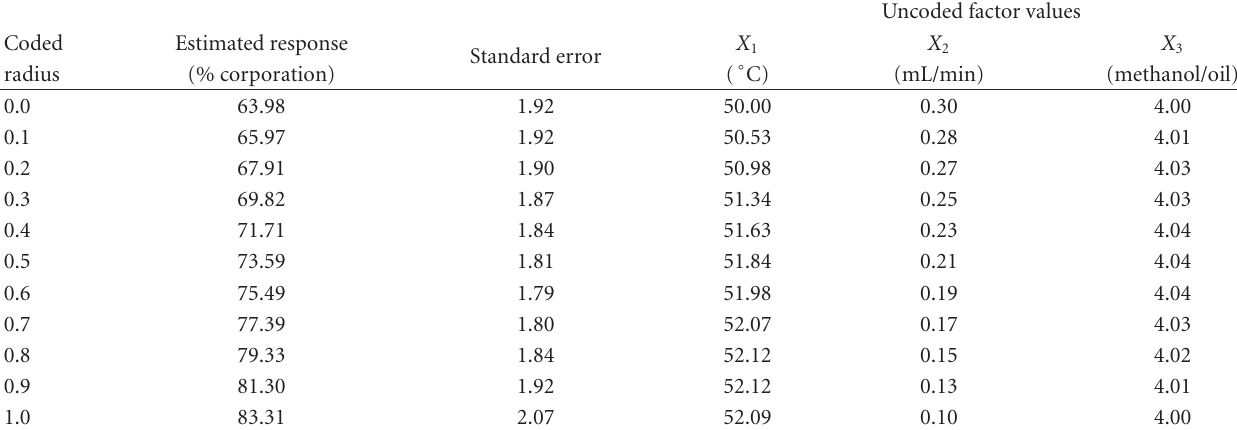
Table 4: Estimated ridge of maximum response for variable percent molar conversion.